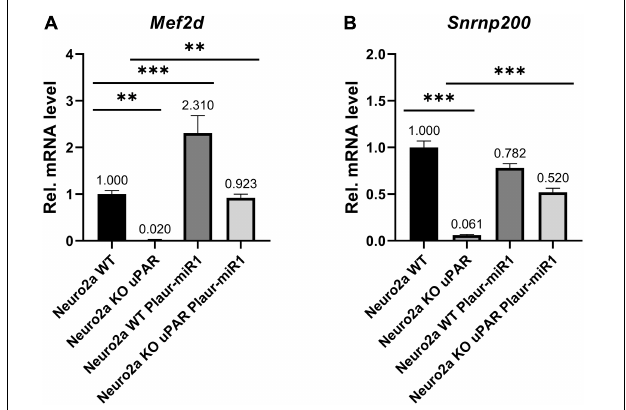
FIGURE 7 | Plaur-miR1 (Plaur-miR1-3p and Plaur-miR1-5p) expression altered the expression of the predicted target genes Mef2d and Snrnp200 in Neuro2a cells. qPCR analysis of (A) Mef2d and (B) Snrnp200 in Neuro2a WT, Neuro2a KO uPAR, Neuro2a WT, and Neuro2a KO uPAR cells after pBl-U6-Plaur-pre-miR1 expression. The data presented as mean ± SEM ( n = 3), normalized to Actb (encodes β -actin) expression as a reference gene. The data were analyzed by using analysis of variance followed by Dunnett’s multiple comparisons test with GraphPad Prism software. Statistical significance is indicated by bars and asterisks as follows: ∗∗ p < 0.01; ∗∗∗ p < 0.001.